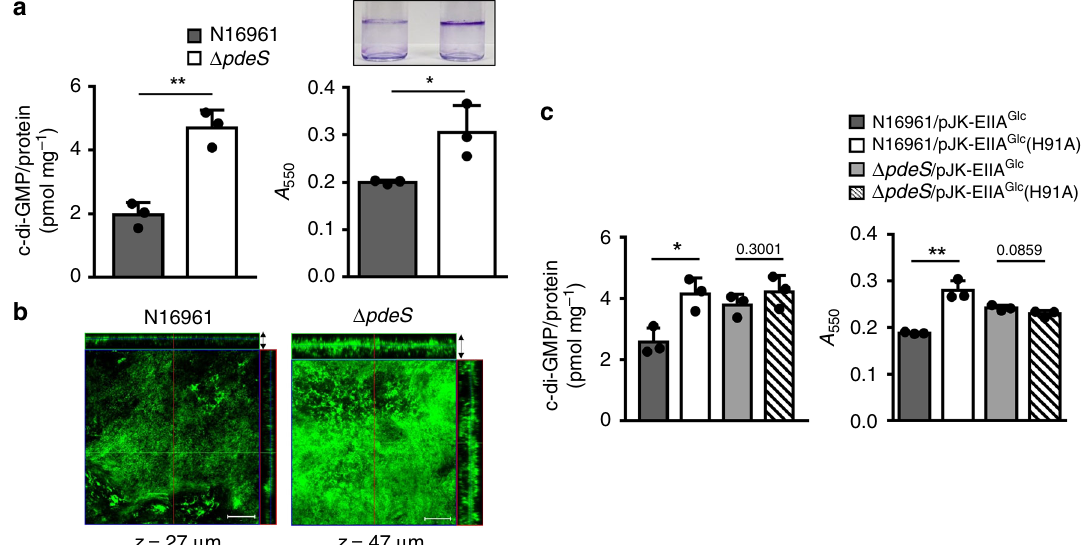
Fig. 3 PdeS regulates the c-di-GMP level and bio fi lm formation. a The intracellular c-di-GMP concentration and the bio fi lm-forming activity of wild-type N16961 and a Δ pdeS strain were measured in the buffered LB medium. The concentration of c-di-GMP extracted from the V. cholerae cells was determined using LC – MS/MS, and normalized with total protein contents. Bio fi lm formation was assessed following static growth of V. cholerae cells for 23 h using a crystal violet staining method 61,65 . The bio fi lm formation was determined at 550 nm. b Bio fi lm formation was visualized using confocal laser scanning microscopy. Scale bar: 50 μ m. c The effect of EIIA Glc on the c-di-GMP hydrolysis activity of PdeS was assessed in vivo. The intracellular c-di-GMP concentration and the bio fi lm-forming activity of wild-type and Δ pdeS V. cholerae strains harboring a pBAD-based expression vector for either wild-type EIIA Glc or dephosphomimetic mutant EIIA Glc (H91A) were determined in the presence of 0.1% arabinose as described in panel a . Statistical signi fi cance was assessed using Student ’ s t -test ( p- values> 0.05 were presented, * p- value < 0.05, ** p -value < 0.01). Shown are the means and SD ( n = 3, independent